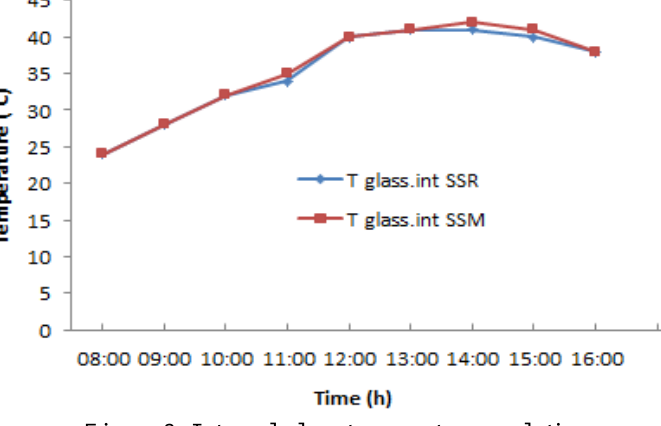
Figure 3. Internal glass temperature evolution